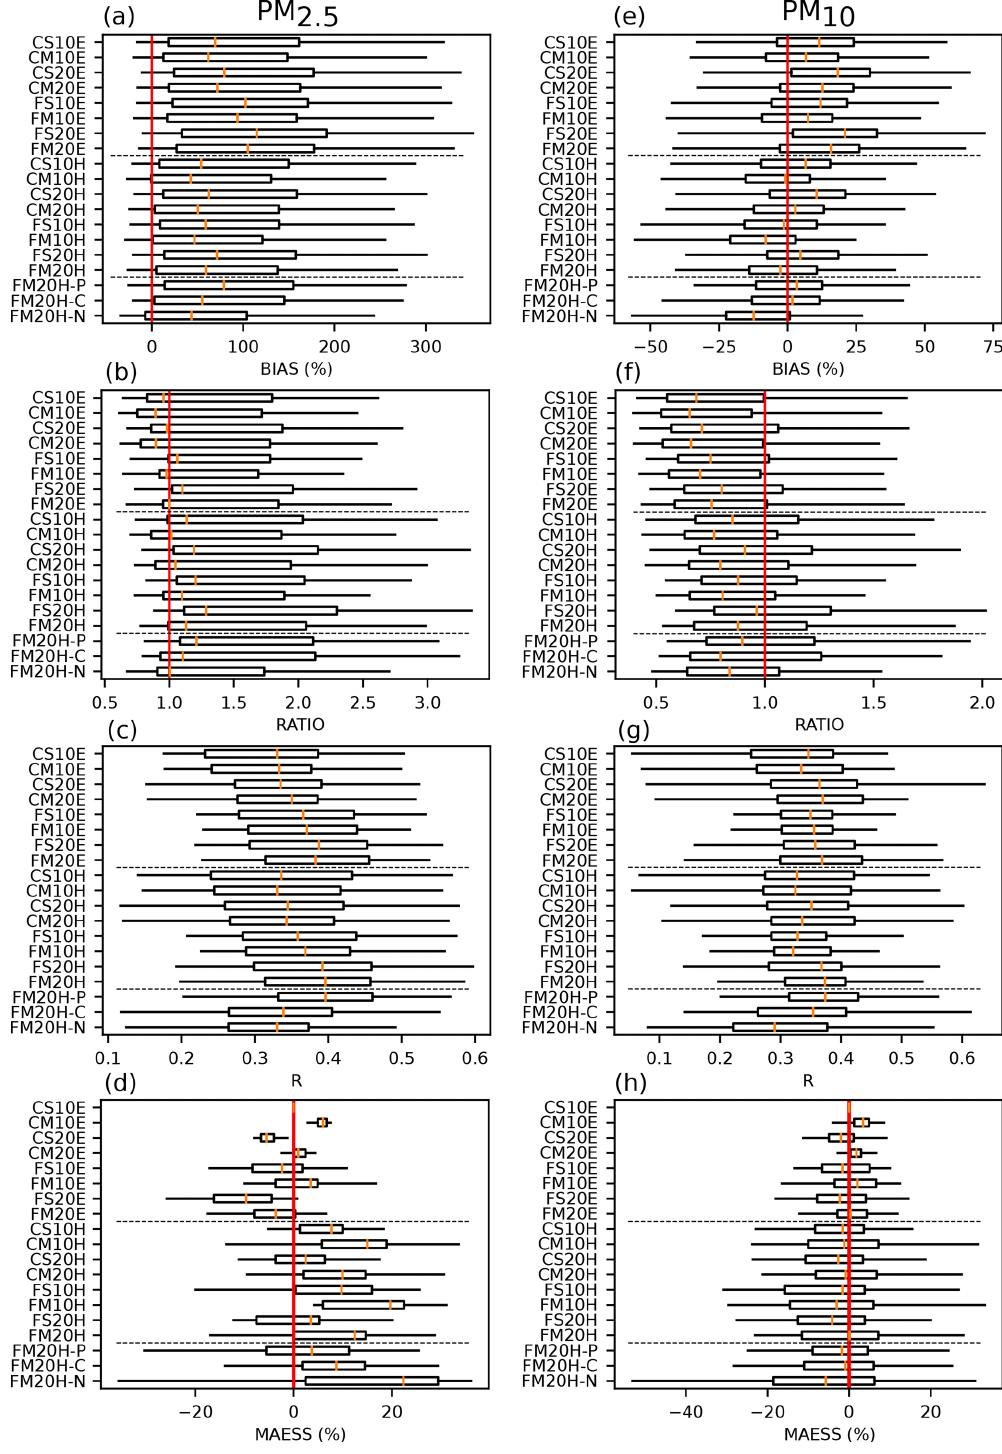
Figure 9. Temporal verification results for daily near-surface minimum PM 2 . 5 (a–d) and PM 10 (e–h) . Row 1: percentage bias (BIAS), row 2: Pearson correlation coefficient ( R ), row 3: ratio of standard deviation (RATIO), row 4: mean absolute error skill score (MAESS) with reference to the base experiment CS10E. Box plots are calculated upon the pointwise verification results at all available stations. Experiments are explained and grouped as in Table